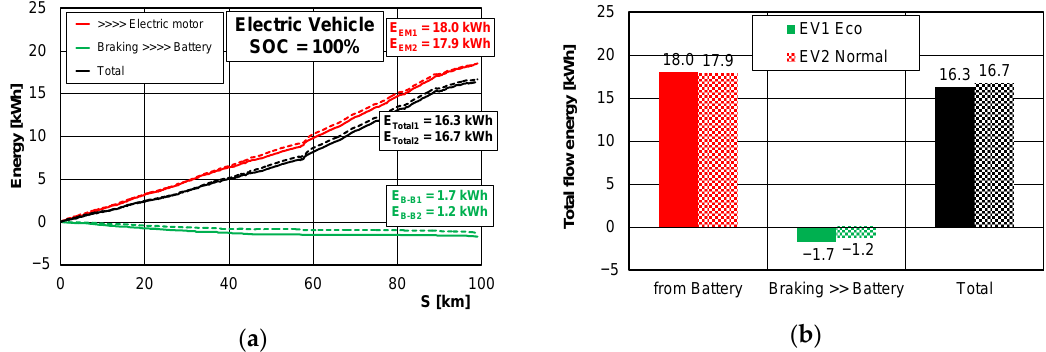
Figure 14. The energy flow for the electric vehicle for different states of charge ( a ) and the accumulated energy demand of the vehicles ( b ).